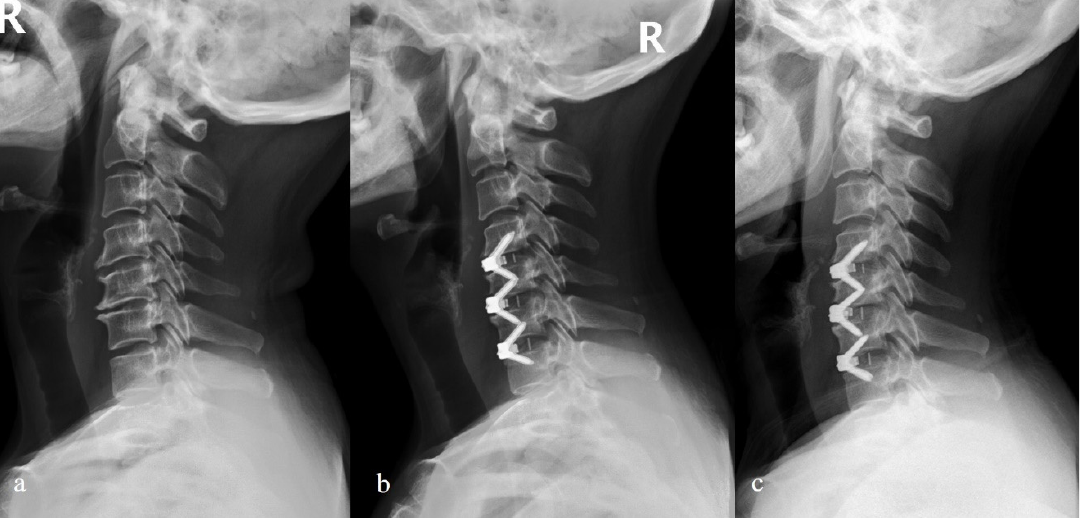
Figure 5. Lateral radiographs of one patient receiving Zero-P spacer system. ( a ) Preoperative C2-C7 Cobb angle was 5 degrees; ( b ) postoperative C2-C7 Cobb angle decreased to -5 degrees (kyphotic); ( c ) the C2-C7 Cobb angle was 0 degrees at the 2-year follow-up.